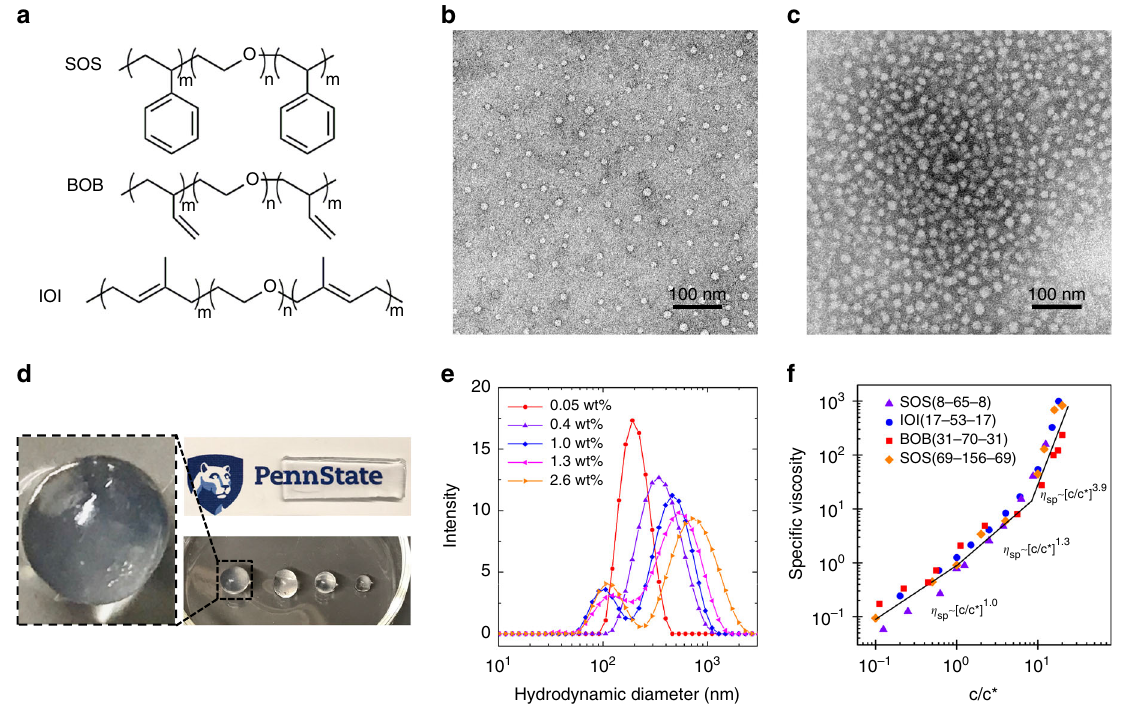
Fig. 2 Polymer structure, morphology characterization, and viscosity measurements. a Chemical structures for the SOS, IOI, and BOB triblock copolymers used in this work. b , c TEM images of the distinctly different fi nal aqueous states formed via rapid-injection using SOS(8-65-8). b Isolated micelles form when using a 0.02 wt% SOS(8-65-8) polymer solution in THF, and c microgels form when using a 1.0 wt% SOS(8-65-8) polymer solution in THF. The TEM images were negatively stained with 0.75% uranyl formate, which show the micelle cores in the dry state. The micelle size determined from TEM is less than the hydrodynamic radius observed by DLS. d Transparent spherical and rectangular hydrogels formed using a 10.0 wt% SOS(8-65-8) polymer solution in THF. The fi nal hydrogel has a polymer content of 5.2 wt% in water (Supplementary Table 5). e DLS plots of the colloidal micelles and microgels formed when SOS(8-65-8) polymer solutions at different concentrations are injected into water. For microgel samples, DLS measurements were run on the supernatant after large aggregates were allowed to settle. f Universal speci fi c viscosity versus normalized polymer concentration ( c / c *) plot for the SOS, IOI, and BOB polymers used in the study. The black lines indicate the expected power laws for dilute, semi-dilute, and entangled concentration regimes. Source data are provided as a Source Data fi le. TEM transmission electron microscopy, DLS dynamic light scattering, THF tetrahydrofuran